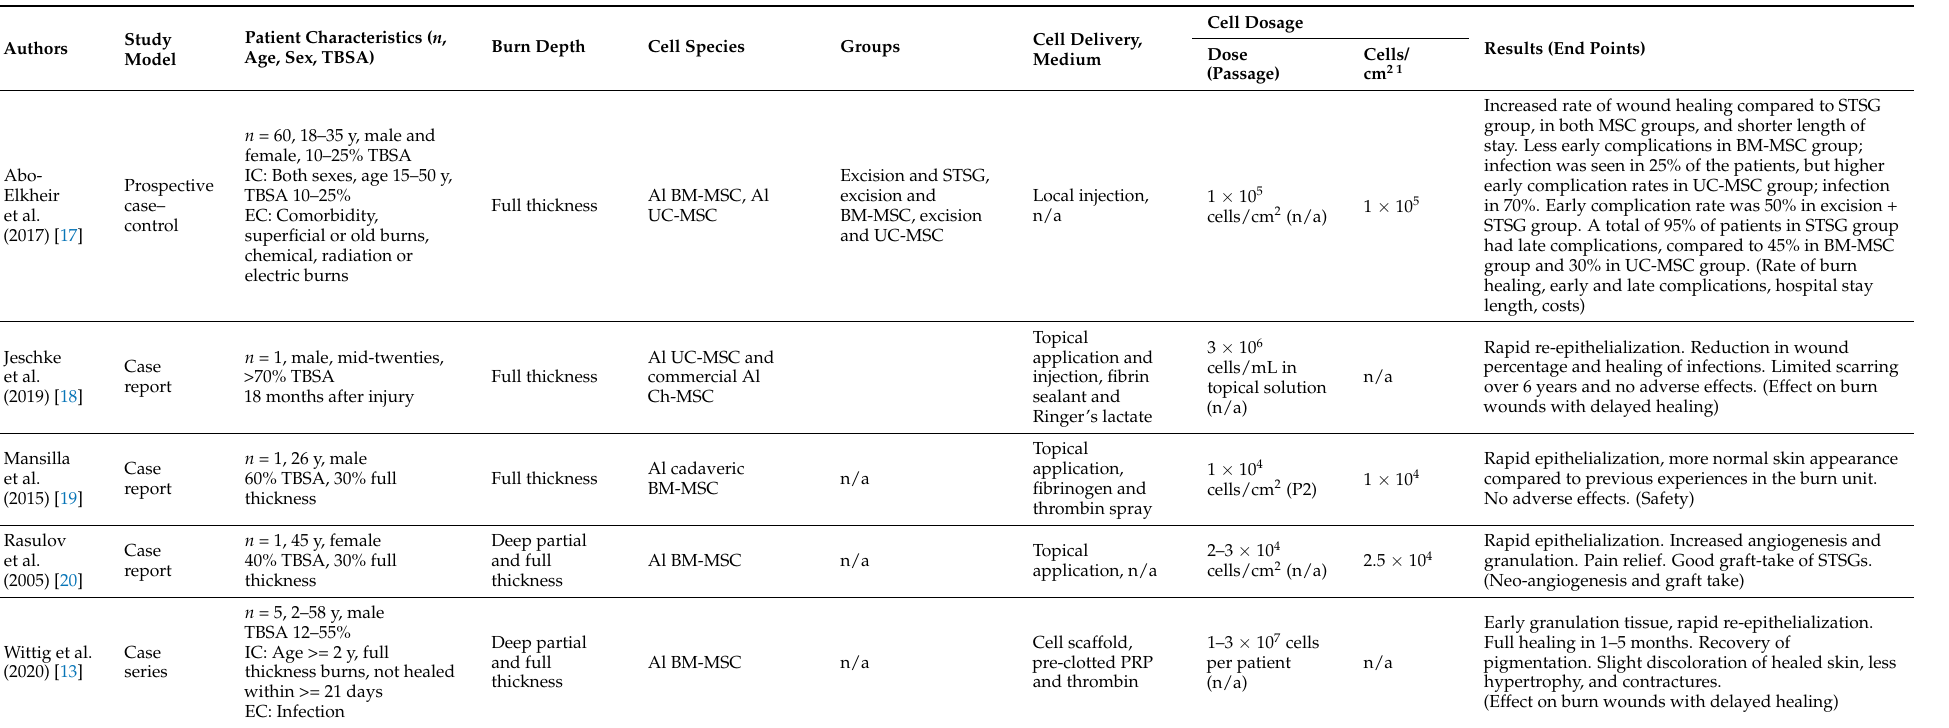
Table 2. Characteristics of studies included—clinical studies ( n =